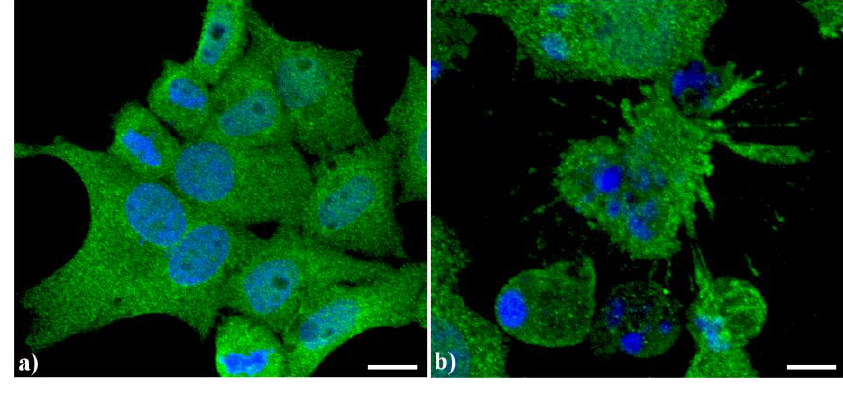
Figure 2. Confocal optical sections after immunolabeling for Endoplasmic reticulum (ER). ( a ) Control HeLa cells; ( b ) Cells treated with 1 μg/mL actinomycin D for 20 h. Cells were fixed and incubated with monoclonal anti-ER marker antibody (1:100 in PBS)